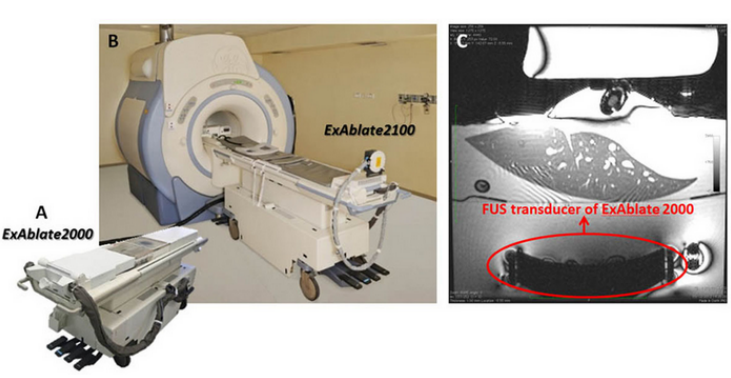
Figure 17. ( A ) ExAblate 2000 System, ( B ) ExAblate 2100, ( C ) ExAblate 2000 FUS Transducer in an MR Image [82].